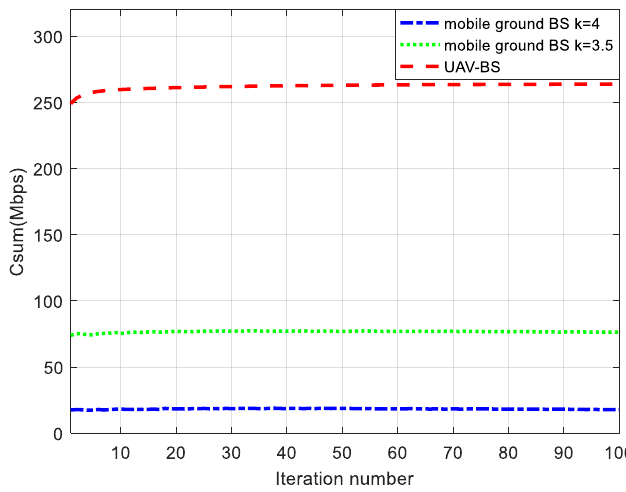
C of ground base station and UAV-BS. Figure 8. Throughput C sum of ground base station and sum